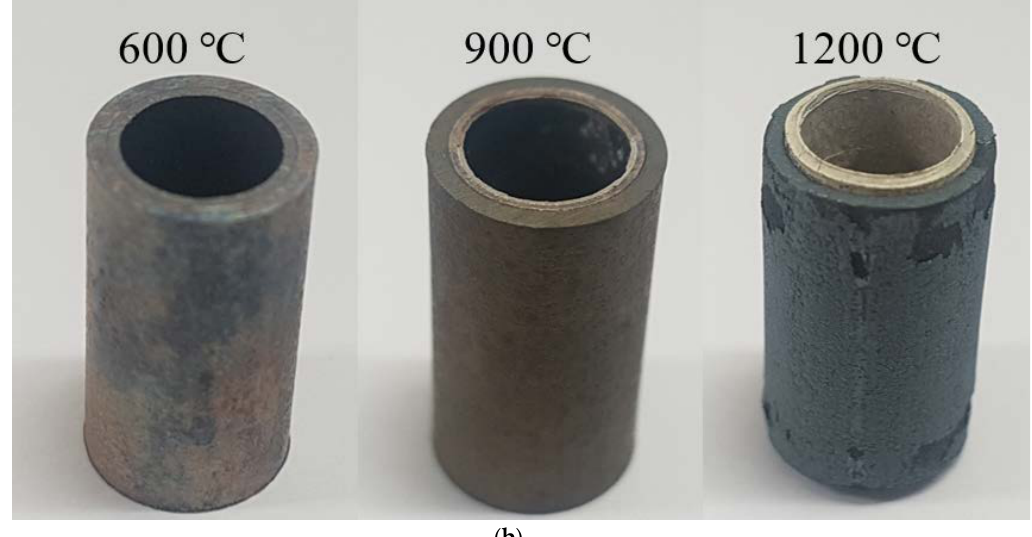
Figure 8. Appearance after maintaining ( a ) the Zircaloy-4-only tube and ( b ) the PST at 600, 900, and 1200 °C for 1 h.